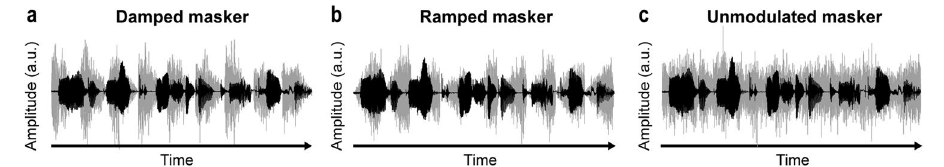
Figure 1. Stimulus design for Experiment 1. Participants listened to sentences (black) to which a 12-talker babble was added with varied SNR levels (grey). Note that for the purpose of clarity, we depict sentence and masker separately. Babble noise was amplitude modulated at a rate of 4-Hz with ( a ) a damped ( b ) a ramped envelope shape; or was ( c ) unmodulated.